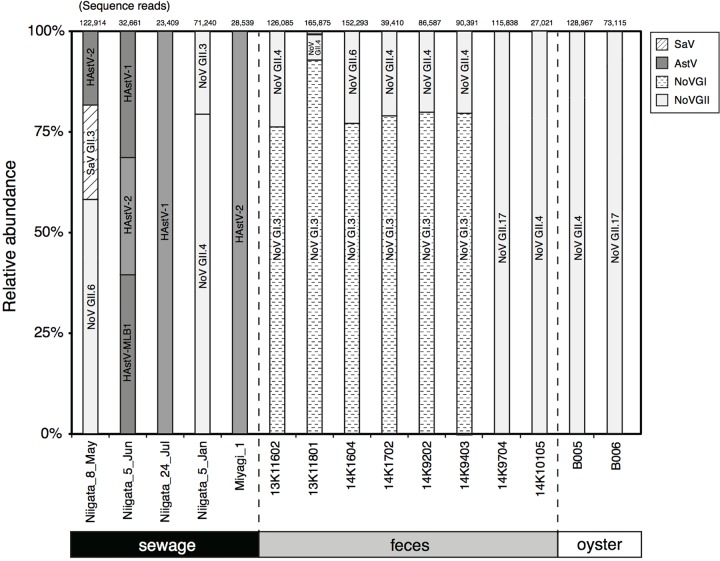
Detection and typing of viruses in samples of human feces, sewage, and contaminated oysters. The number of reads obtained by MiSeq sequencing is shown at the top of the panel, and relative abundance of the sequence reads affiliated with a specific genotype of viruses is shown in the figure. The identified genotypes are indicated in the bars.